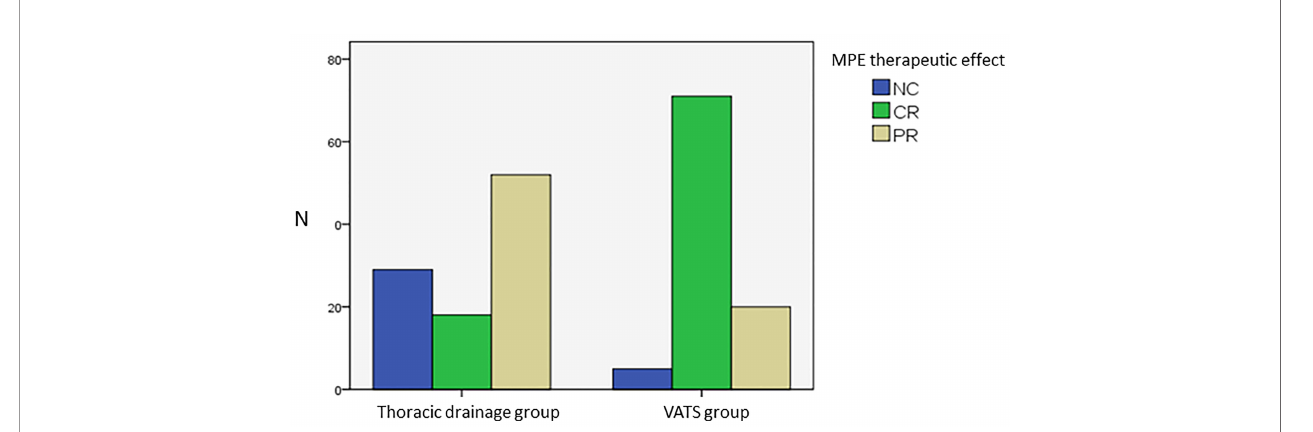
FIGURE 2 | Analysis of MPE therapeutic effect of two groups.